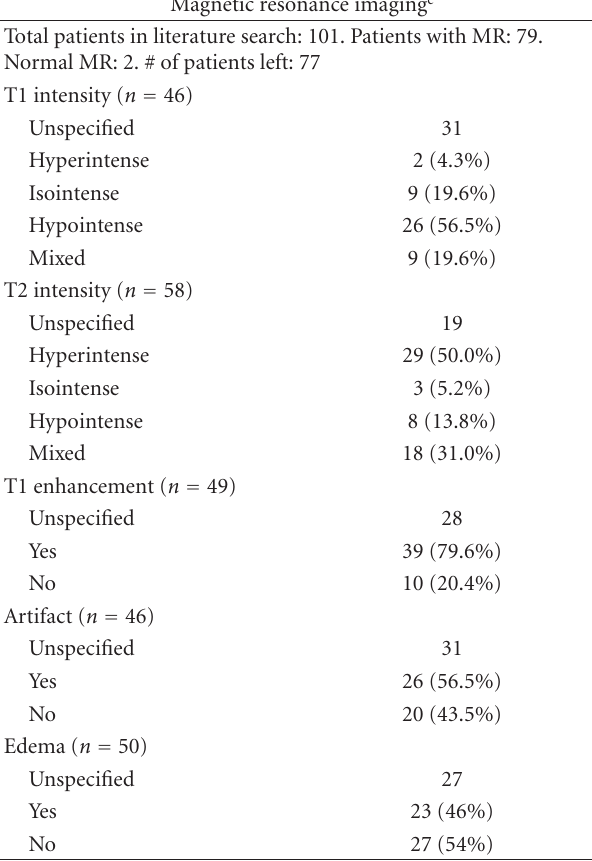
Table 3: Meningioangiomatosis appearance on magnetic resonance imaging. Summary of the MR head imaging findings of meningoan- giomatosis cases reported in the literature. Magnetic resonance imaging c